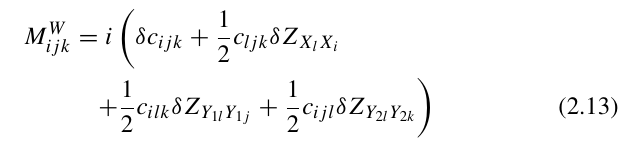
For decays involving fermions only the first topology is of relevance. Depending on the considered decay, differ- ent generic diagrams are associated with these